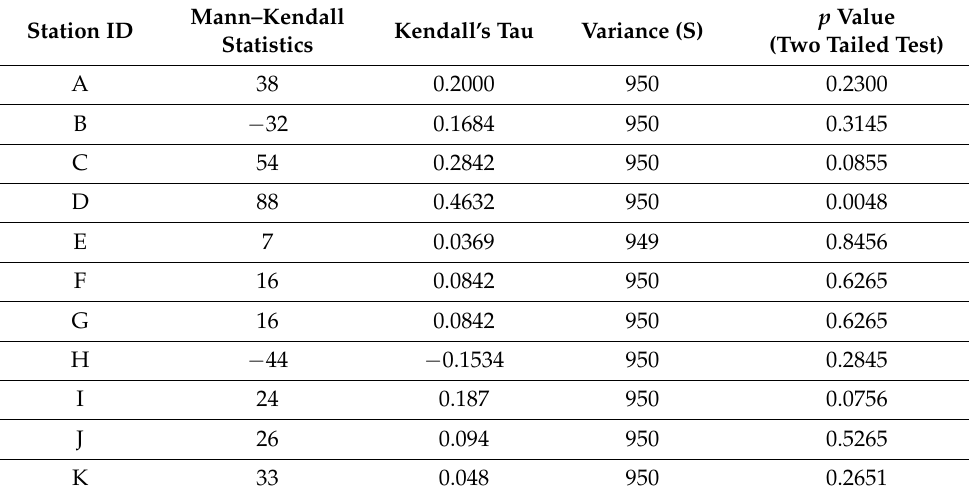
Table 4. Mann–Kendall test results for T max for Meteorological